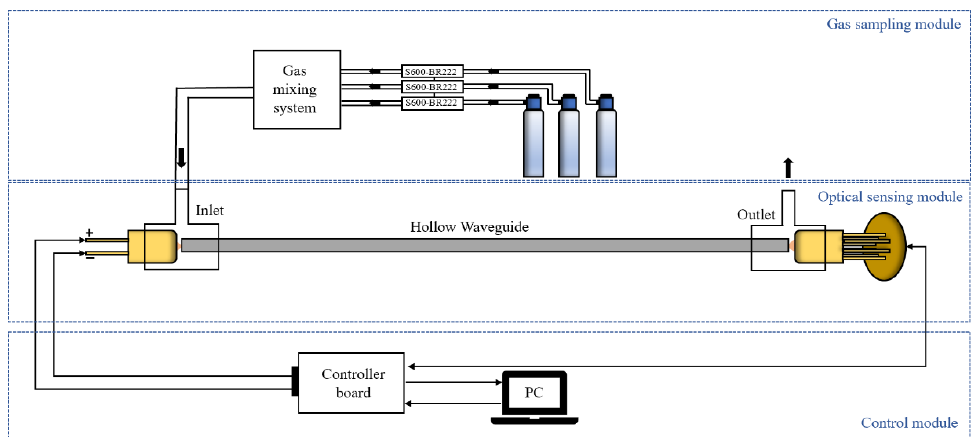
Figure 1. Schematic diagram of the sensing system.